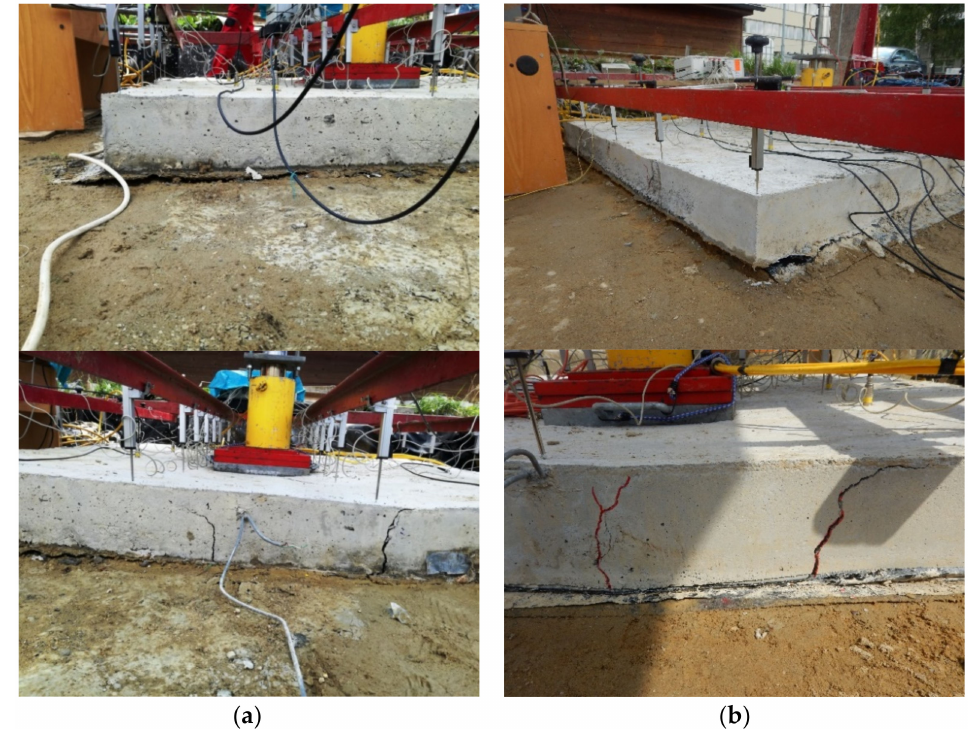
Figure 18. Slab: ( a ) centrically loaded slab G10; ( b ) eccentrically loaded slab G11.